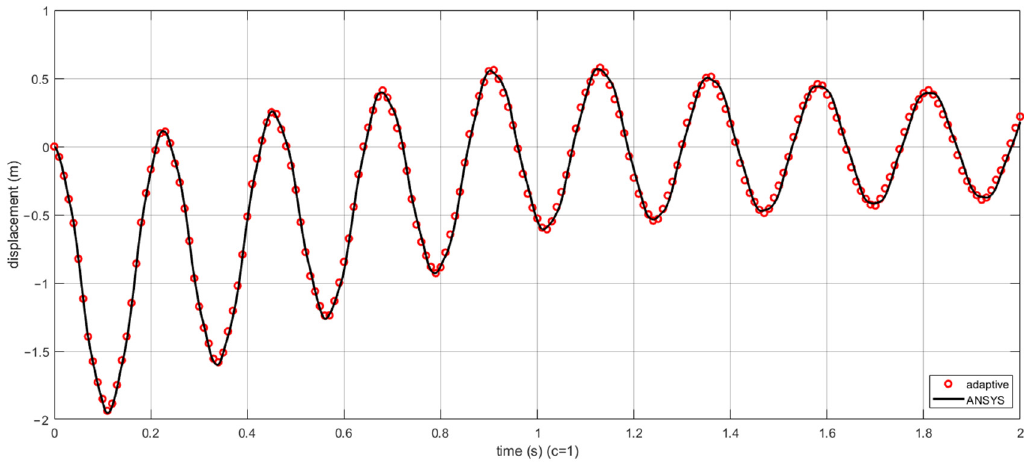
Figure 21. The transient vertical displacement at point A with damping ( 𝑐 = 1 Ns/m ) and Δ𝑡 = 0.001 s under transient loading with finite decreasing time.